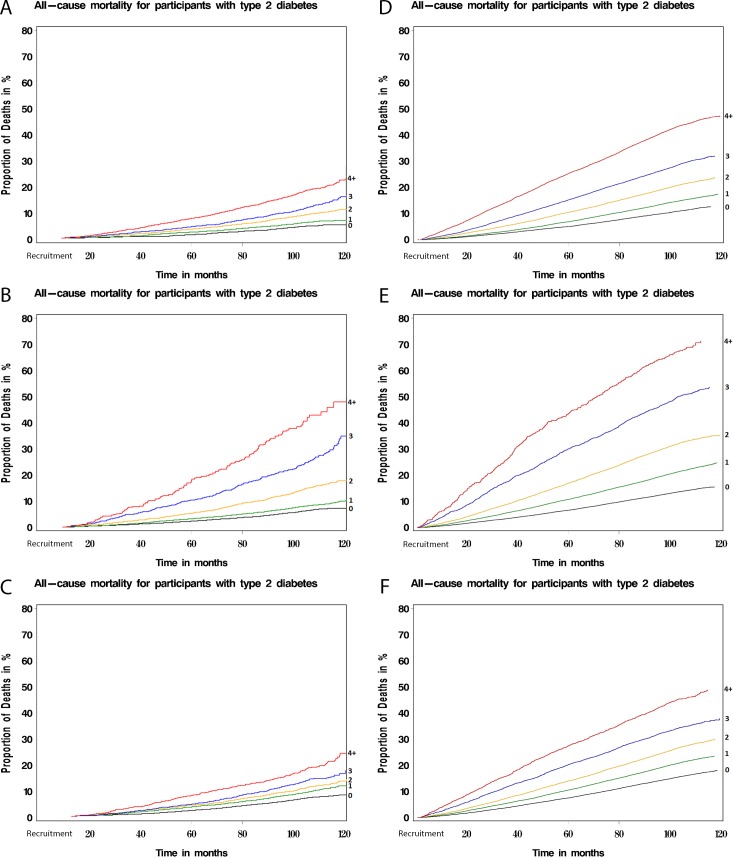
Cumulative survival plot showing probability of all-cause mortality among type 2 diabetes participants with different levels of multimorbidity.(A) Total multimorbid conditions in UK Biobank; (B) concordant conditions in UK Biobank; (C) discordant conditions in UK Biobank; (D) total multimorbid conditions in Taiwan NDCMP; (E) concordant conditions in Taiwan NDCMP; (F) discordant conditions in Taiwan NDCMP. NDCMP, National Diabetes Care Management Program.